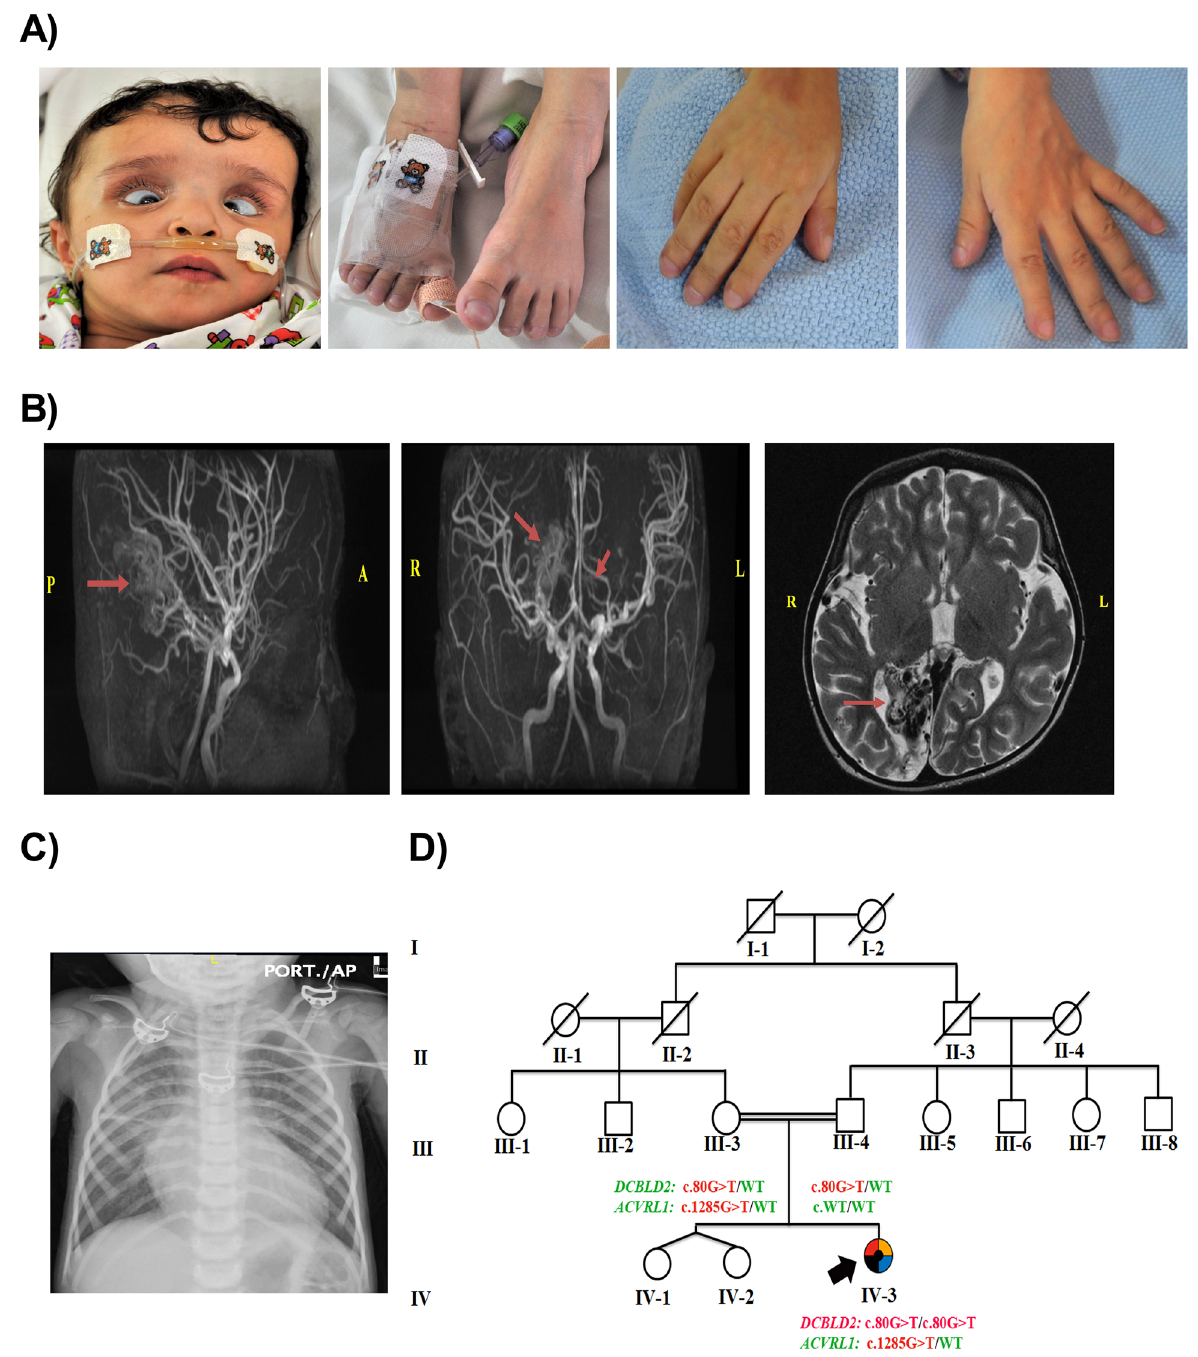
Figure 1. The index’s case presentation and genetics pedigree information. ( A ) Clinical features of the proband showing dysmorphic features, including frontal bossing, hypertelorism, deep-seated eyes, bilateral strabismus, corneal opacity, depressed nasal bridge, upturned nose, micrognathia, low-set ears, brachycephaly, and high arched palate. The hands and feet appeared small with broad thumbs. ( B ) Brain MRI and MRA: MRA (sagittal and coronal sections) showing right posterior cerebral and small left posterior-central gyrus arteriovenous malformations. ( C ) Chest X-ray showing cardiomegaly and congestion of the pulmonary vessels. T2-weighted axial section MRI shows right occipital cystic encephalomalacia. ( D ) Pedigree of the consanguineous Saudi family who had a daughter affected with a (black square) Restrictive cardiomyopathy, (blue square) Thrombocytopenia, (red square) Spasticity, (yellow square) Developmental delay and (black circle) Dysmorphic features; pedigree constructed from the details provided by the index’s mother, generated using (https:// www. proge nygen etics. com); squares (males); circles (females); slashed symbols (deceased individuals); annotated symbols (affected individuals); open symbols (unaffected individuals); arrowheads